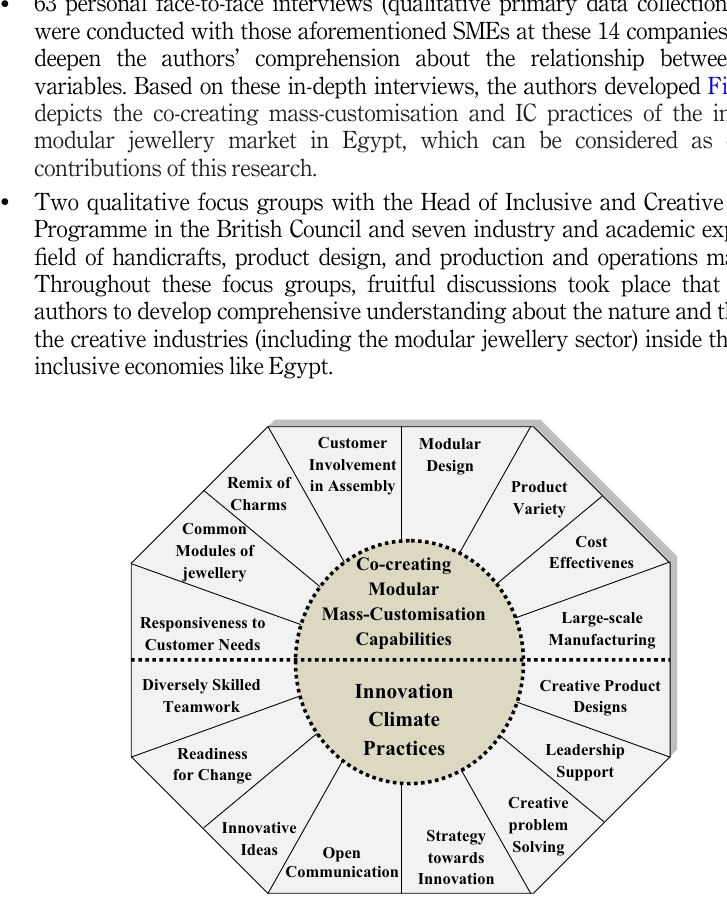
Figure 2. The co-creating mass- customisation and IC practices of